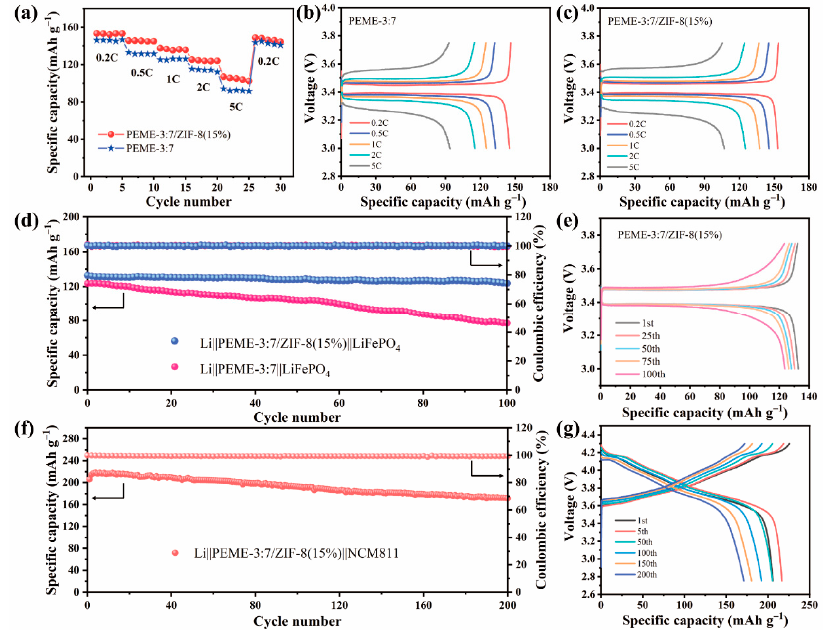
Figure 7. ( a ) Rate performances of the Li||LiFePO 4 cells using PEME-3:7 and PEME-3:7/ZIF-8(15%). Charge–discharge curves of the ( b ) Li||PEME-3:7||LiFePO 4 cell and ( c ) Li||PEME-3:7/ZIF- 8(15%)||LiFePO 4 cell at 0.2 C, 0.5 C, 1 C, 2 C, and 5 C. ( d ) Cycling performances of the Li||PEME- 3:7||LiFePO 4 and Li||PEME-3:7/ZIF-8(15%)||LiFePO 4 cells at 0.5 C. ( e ) Voltage profiles of the Li||PEME-3:7/ZIF-8(15%)||LiFePO 4 cell for different cycles at 0.5 C. ( f ) Cycling performances of the Li||PEME-3:7/ZIF-8(15%)||NCM811 cells at 0.2 C. ( g ) Voltage profiles of the Li||PEME-3:7/ZIF- 8(15%)||NCM811 cell for different cycles at 0.2 C.